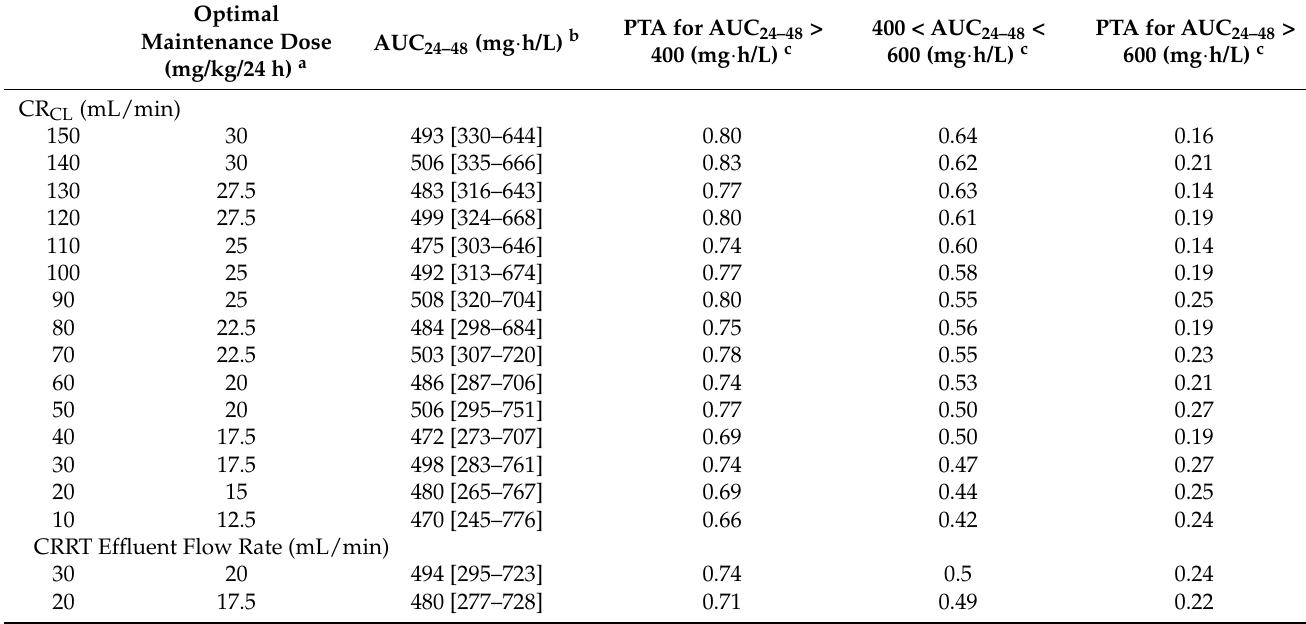
Table 3. Optimal maintenance dose based on simulations with the final model.